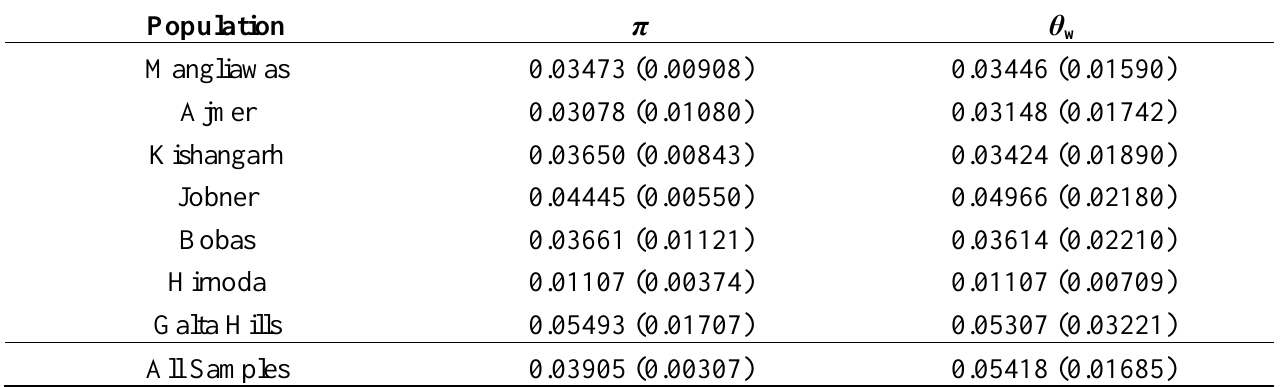
Table 3. Nucleotide diversity of the ITS1- 5.8S- ITS2 fragment for the seven populations. π and θ refer to nucleotide diversity according to Nei and Li [43] and Watterson’s w parameter [32] respectively. Figures in parenthesis denote standard deviation.